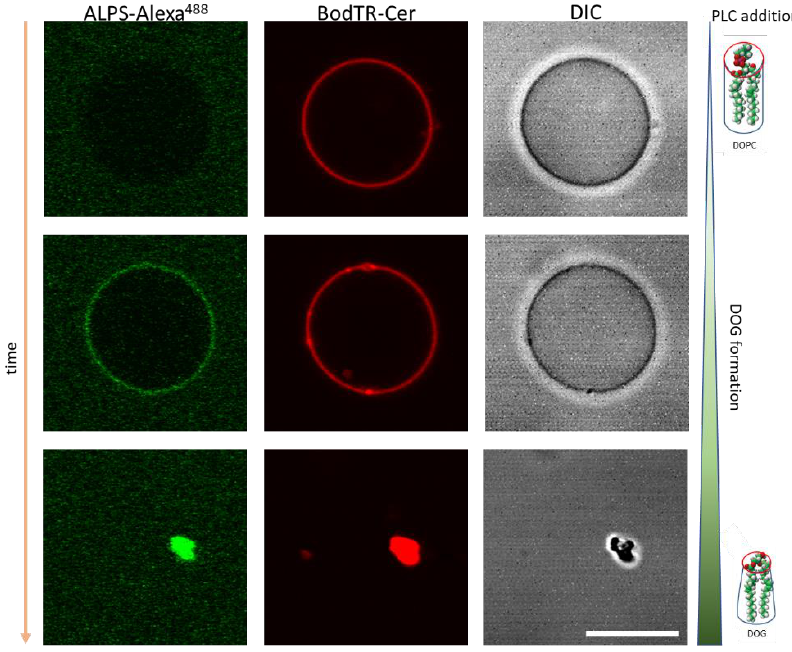
Figure 3. DOG generation by PLC on DOPC GUVs promotes ALPS binding. DOPC GUVs labeled with BodipyTR-ceramide (red channel) in the presence of ALPS-Alexa488 (green channel) and PLC. Scale bars 10 μm. Extracted from [46].